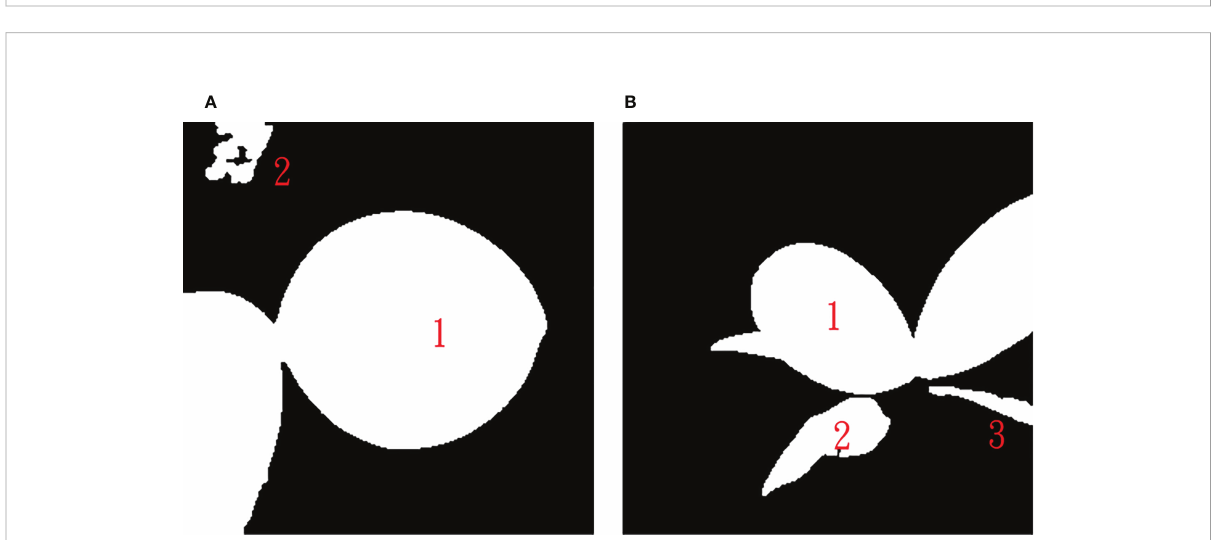
FIGURE 7 (A – C) Examples of the predicted leaf region (mask).